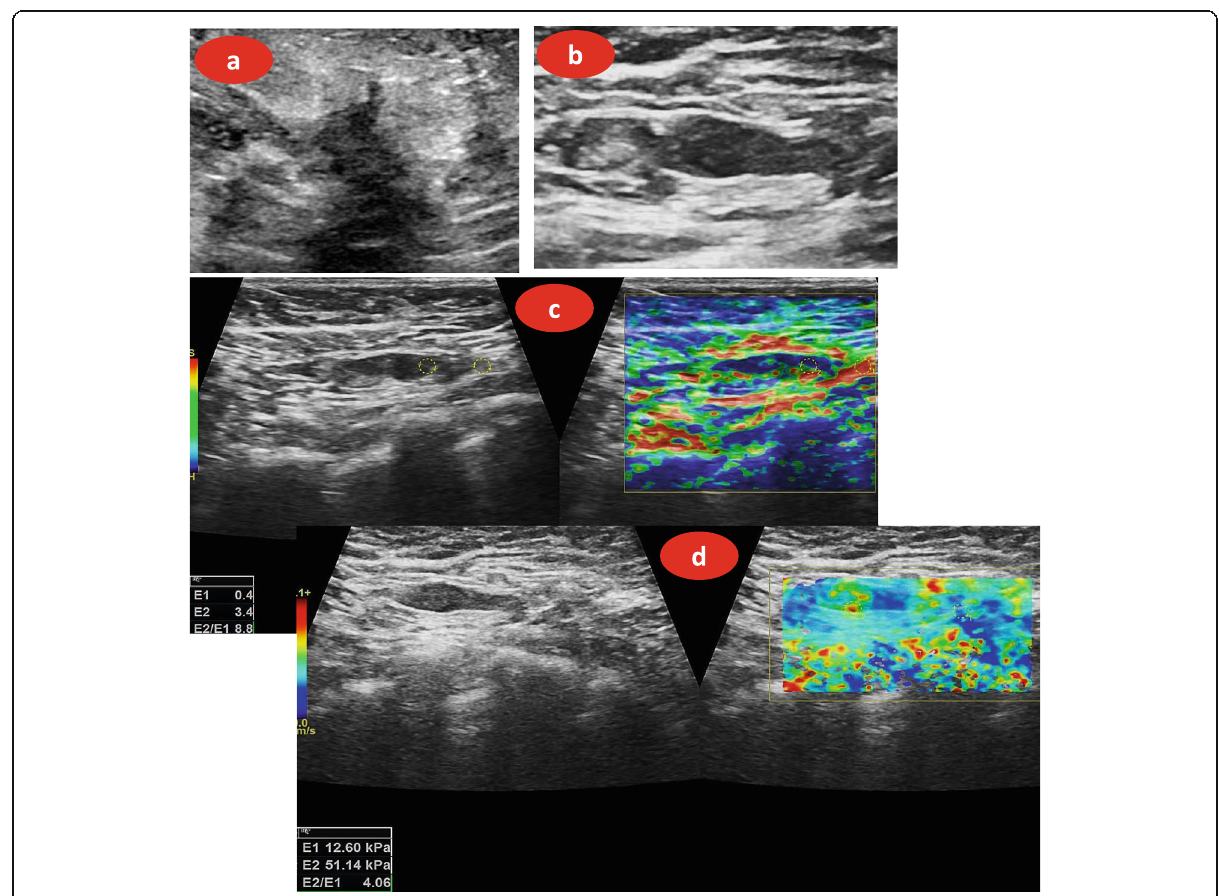
Fig. 9 A 45-year-old lady with positive maternal family history, presenting for screening